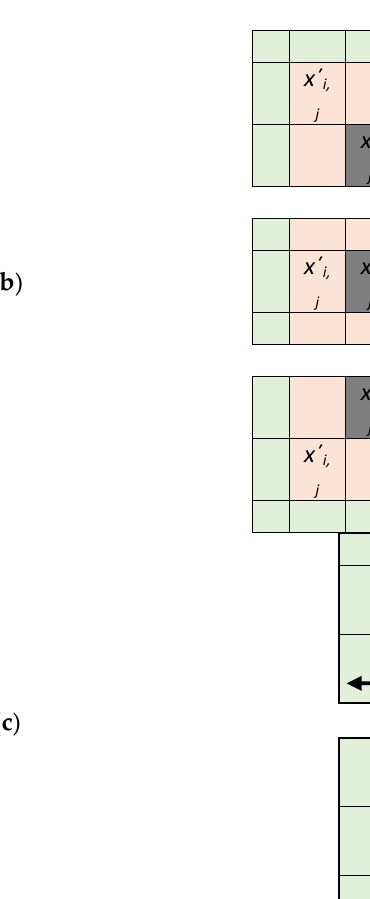
. ( c ) Shows a new i , j